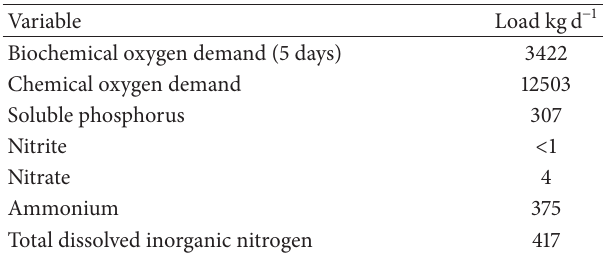
Table 1: Inputs of organic matter and inorganic dissolved nutrients of La Salada